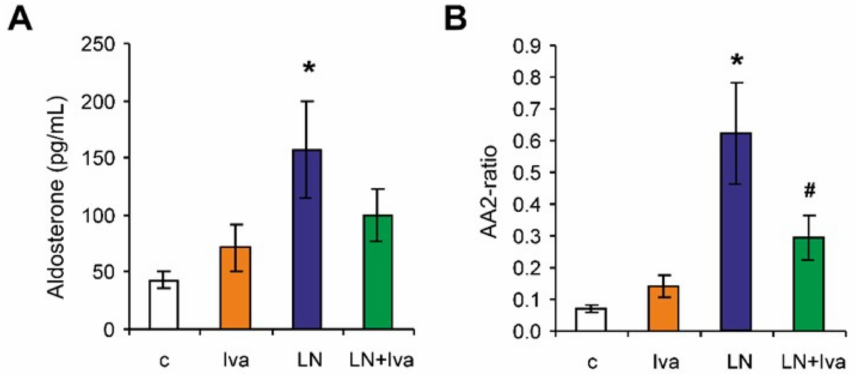
Figure 5. The influence of ivabradine (LN + Iva) on the serum level of aldosterone ( A ), and the aldosterone/Ang II (AA2) ratio ( B ) in L -NAME-treated rats. Wistar controls (c); L -NAME (LN); ivabradine (Iva); n = 6 per group; * p < 0.05 vs. c; # p < 0.05 vs. LN; results are expressed as mean ± SEM.